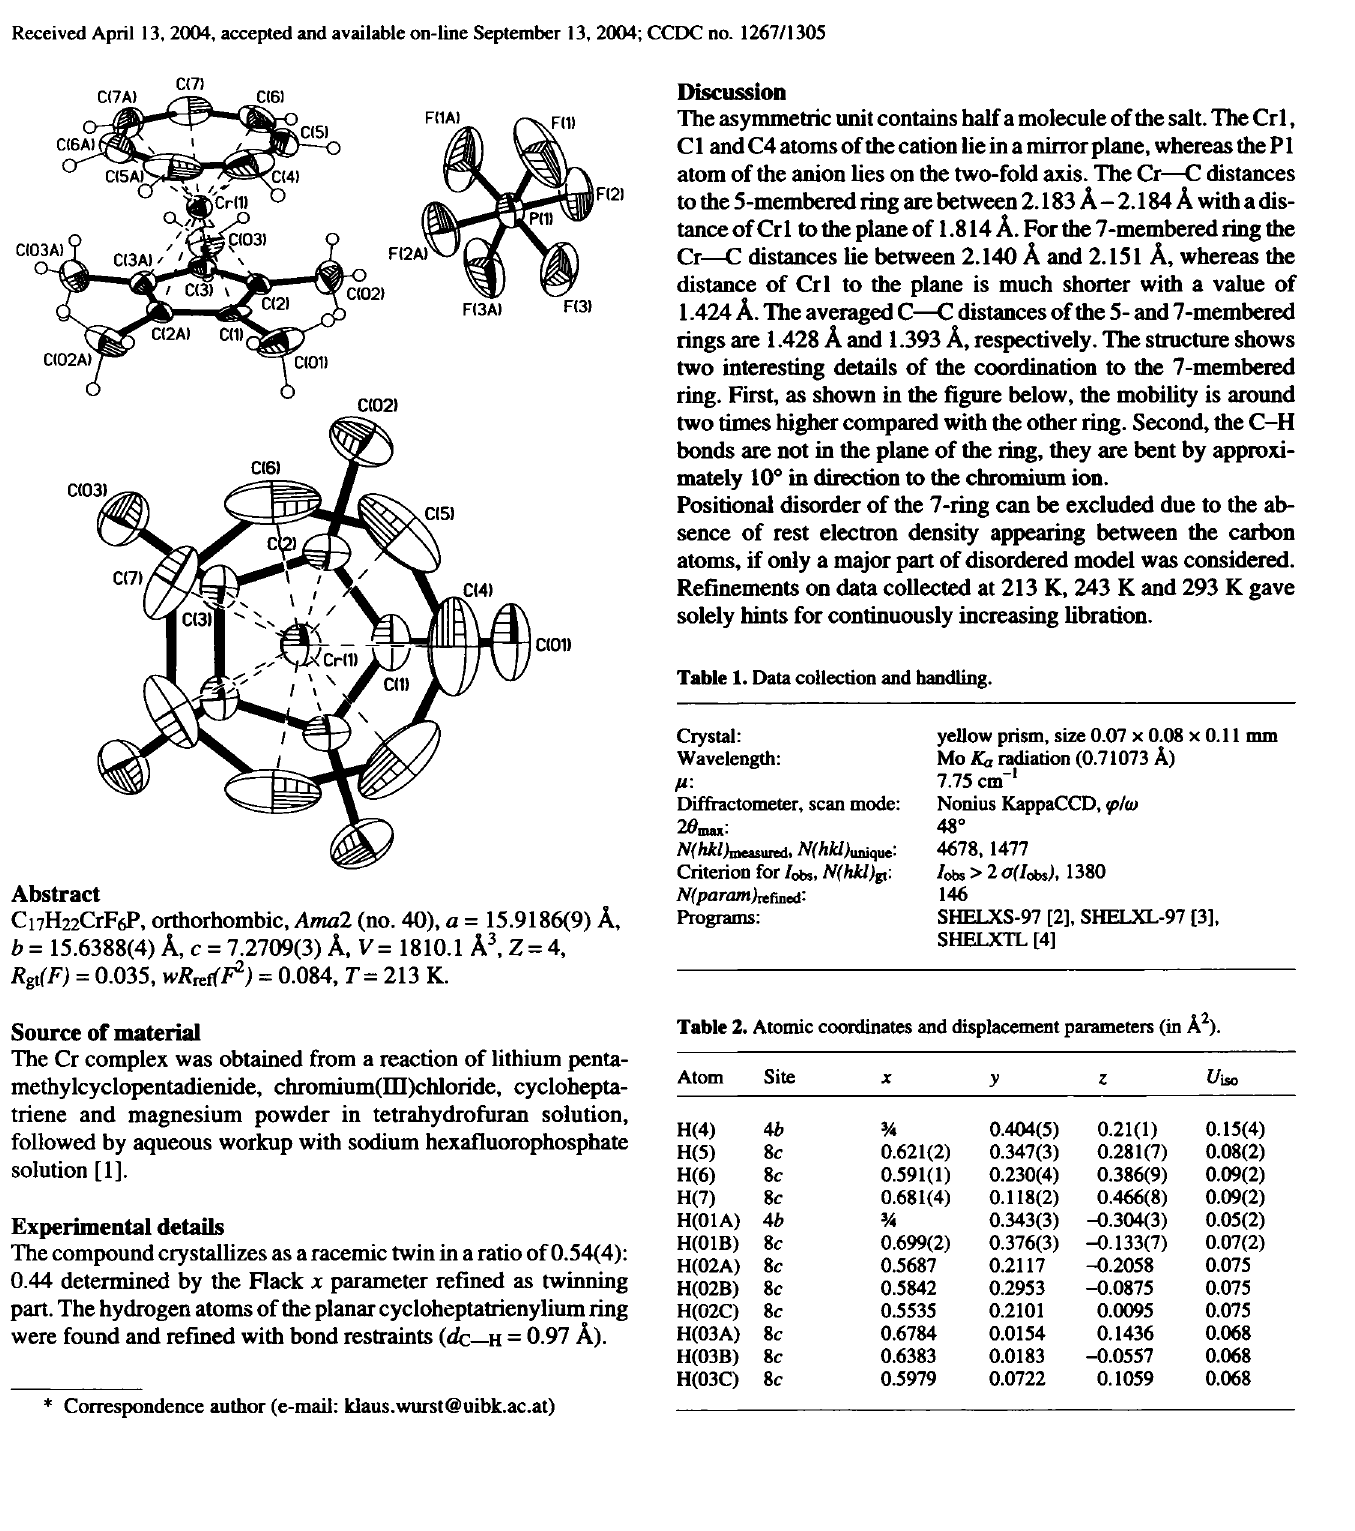
Table 2. Atomic coordinates and displacement parameters (in Â 2